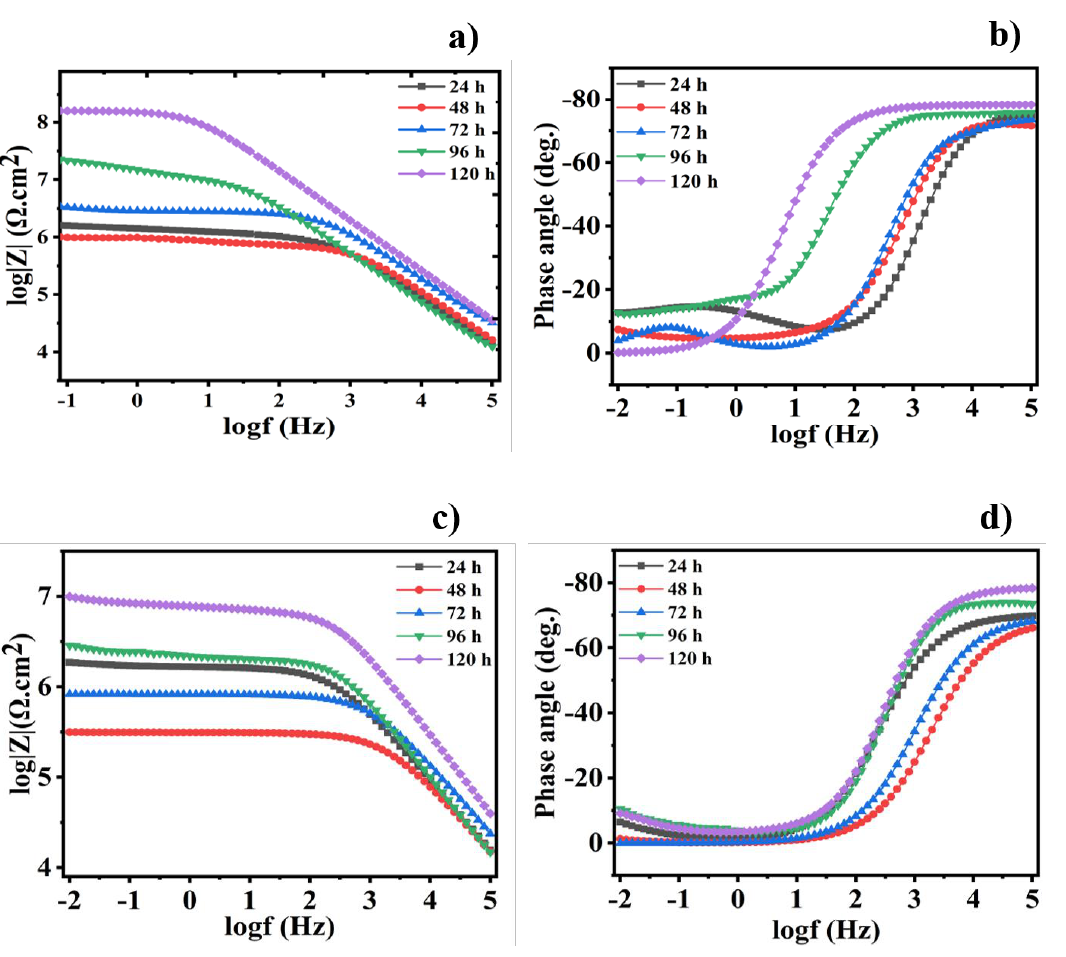
Figure 9. ( a , c ) Bode and ( b , d ) the corresponding phase angle plots for the scratched reinforced epoxy / CeO 2 / DDA and epoxy / CeO 2 / NMTU coatings, respectively, after di ff erent immersion times in 3.5 epoxy/CeO 2 /DDA and epoxy/CeO 2 /NMTU coatings, respectively, after different immersion times in wt.% NaCl at room 3.5 wt. % NaCl at room temperature.